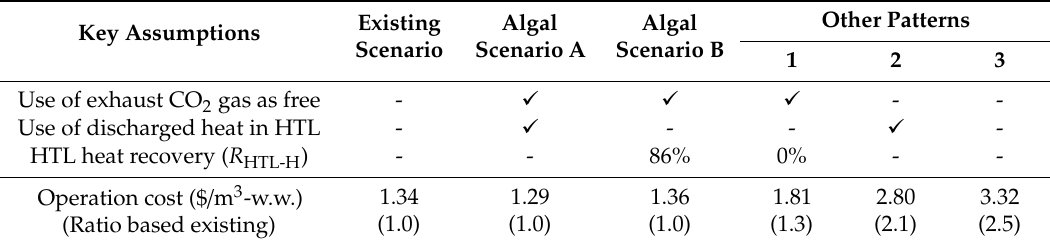
Table 2. Productivity in microalgal oil production from previous studies (No. 1–7) and applied values in this study (No. 8). Table 6. Cost change by changing key assumptions (treatment volume is 81.6 m 3 -w.w. / d).